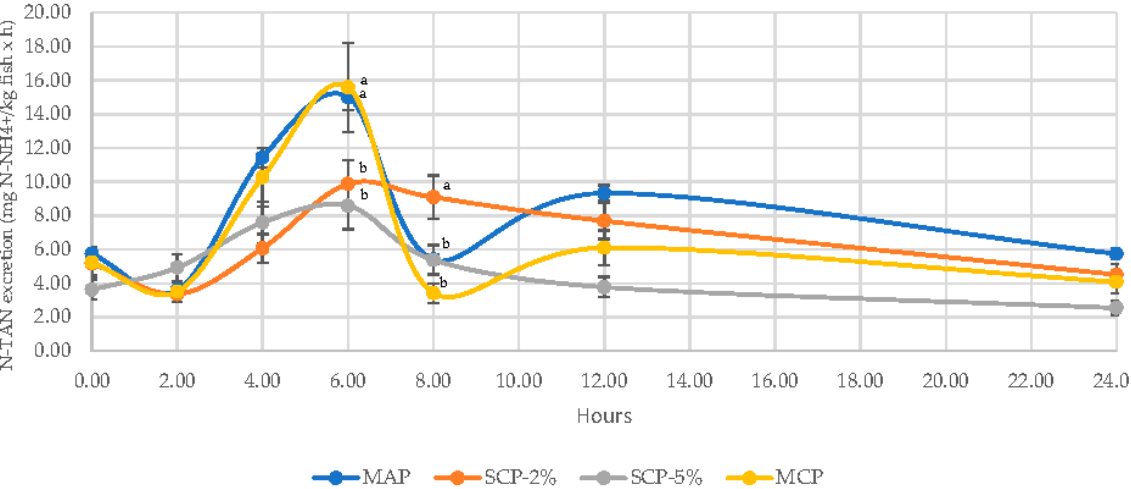
Figure 3. Daily pattern of soluble total ammoniacal N excretion rate (expressed in mg of N-NH 4+ per kg of fish biomass and hour) of rainbow trout fed four inorganic P sources. Each point represents the average ( ± SE) of four tanks. Different superscripts indicate statistically significant differences with p < 0.05. A Newman–Keuls test was used to compare the means. The amount of N excretion was determined based on N-TAN concentration in water every two hours after feeding over a 24-h period.